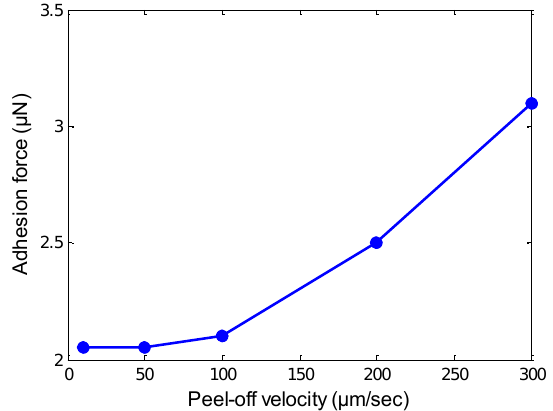
Figure 5. The measured maximum pull-off forces with respect to peel velocity.